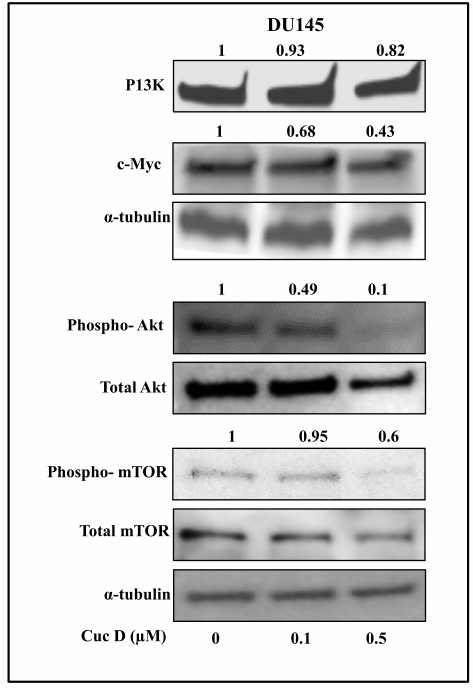
Figure 5. Effect of Cuc D on key effectors involved in glucose metabolism and cell survival in PrCa cells. Effect of Cuc D on protein levels of PI3K, pAKTSer473, c-Myc and phospho-mTOR in DU145